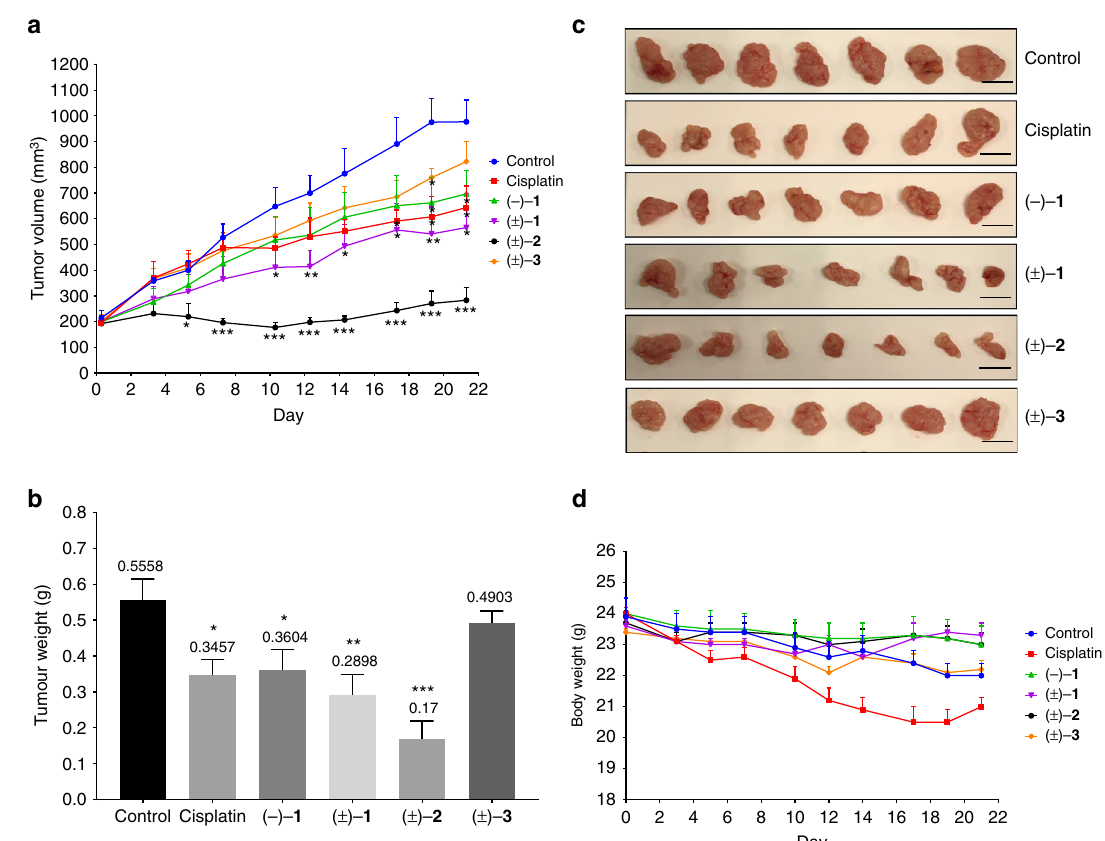
Fig. 5 In vivo studies of Isodon diterpenoids. BALB/c nude mice xenografted with SW480 cells were randomised into different groups ( n = 7 per group) and received intraperitoneal injections of compounds (natural ( – ) − 1 or synthetic (±) − 1 – 3 , 10 mg/kg) three times weekly. Mice injected with saline served as controls. The experimental period lasted for 21 days, after which the mice were killed and their tumours and organs harvested and weighed. Treatment with natural ( – ) − 1 and synthetic (±) − 1 – 3 could inhibit xenograft tumour growth, weight and volume, without signi fi cant effects on mouse body weight. a Tumour volumes throughout the 21-day experimental period. b Tumour weights at experimental endpoint. c Photographs of tumours at experimental endpoint. Scale bar, 10 mm. d Mouse body weight throughout the 21-day experimental period. For ( a ), ( b ) and ( d ), data are expressed as means from seven mice. Error bars represent ± SEM. * P < 0.05, ** P < 0.01, *** P < 0.001 compared to control (Student ’ s t